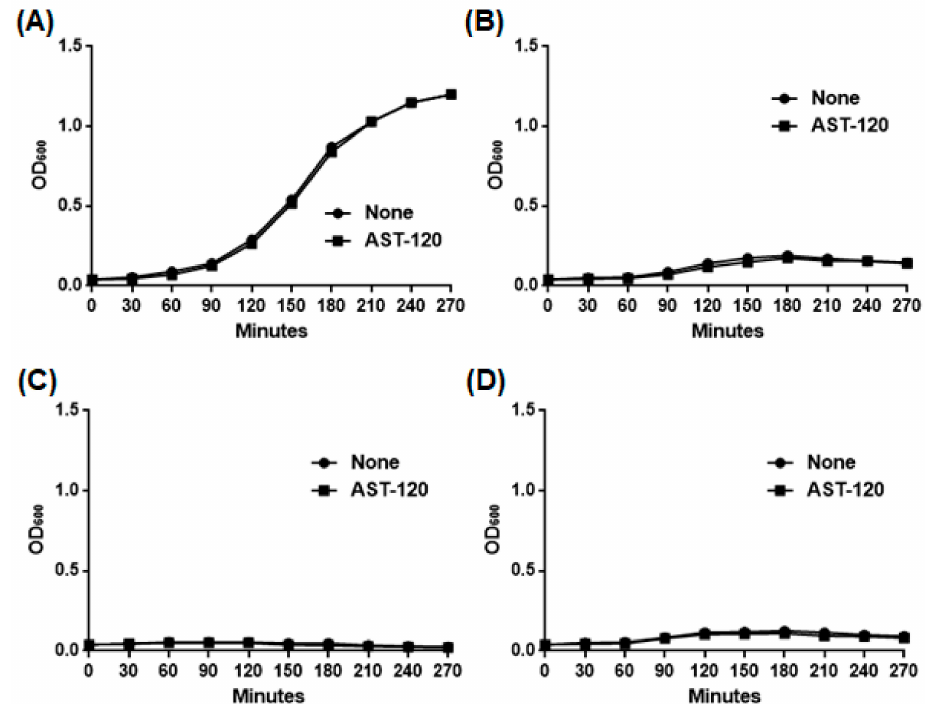
Figure 5. Growth of the PAO1 strain when cultured with or without indicated drugs in the presence and absence of AST-120. Bacteria were grown in LB medium in the presence and absence of 30 mg of AST-120 without drug ( A ) or together with fosfomycin ( B ), colistin ( C ) or amikacin ( D ). The bacterial growth was monitored by measuring OD 600